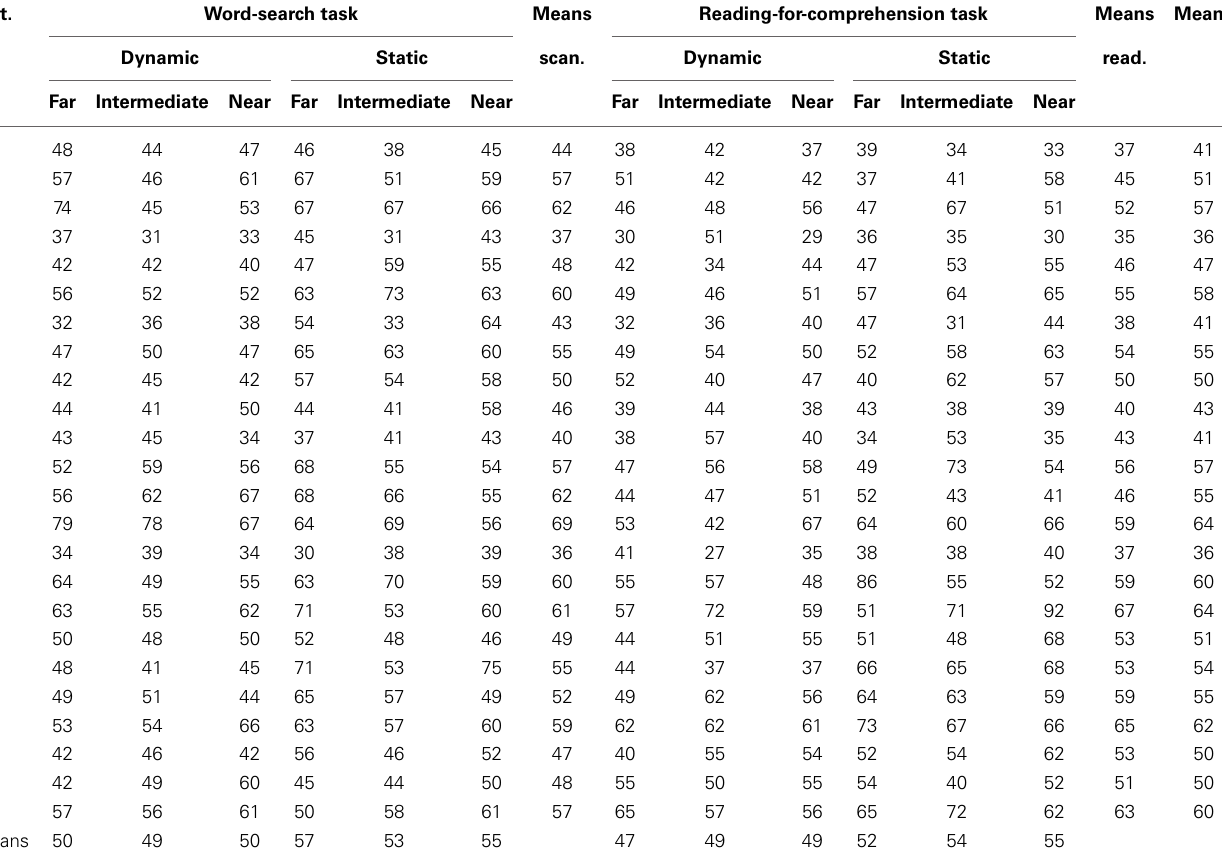
Table 3 | Proportion of Scanning fixations (as %) for each participant averaged over conditions according to the classifier algorithm.